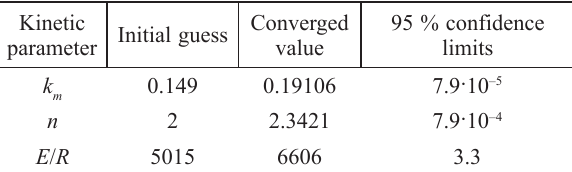
Table 6 – Kinetic parameter values for the power law model given by eq. 4 and the 95 % confidence limits Converged Kinetic Initial guess parameter